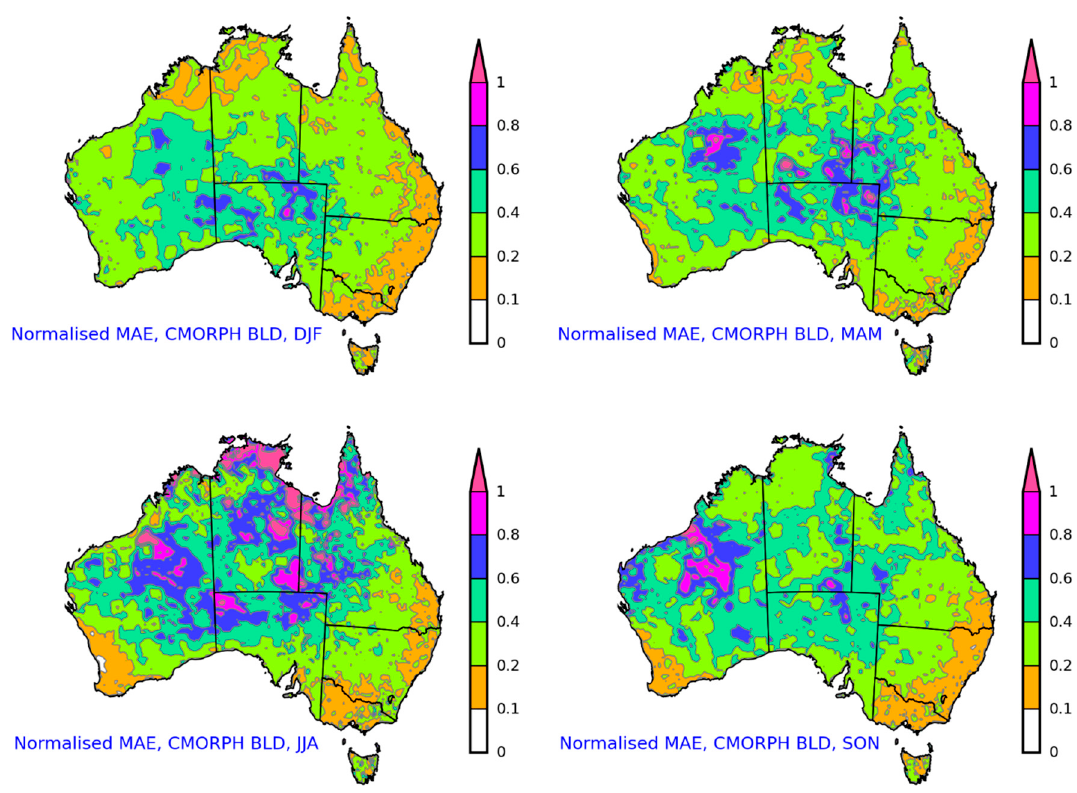
Figure 8. Gridded comparison categorised by seasons from January 2001 to December 2018 using AWAP as truth. Normalised mean average error from CMORPH BLD is displayed.